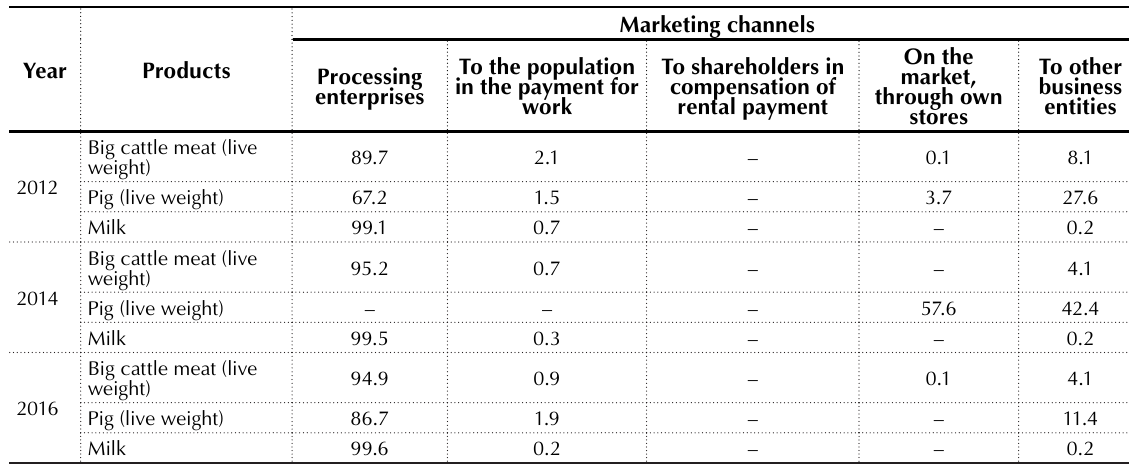
Source: Compiled based on Statistical Yearbook of Ukraine.